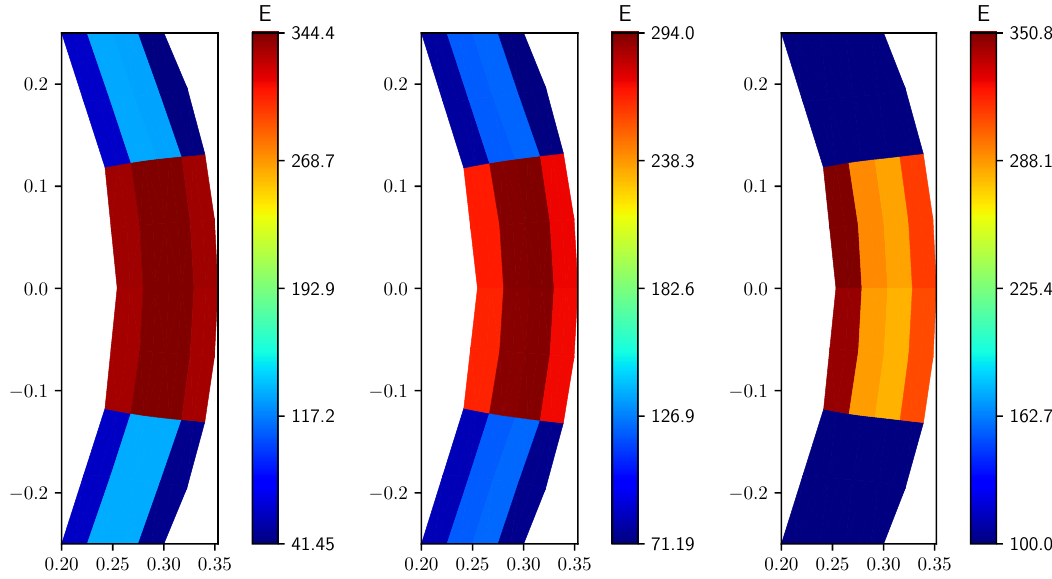
Figure 5. Young modulus E fields, discretization l = 2 with different E min = 10 Pa ( left ), 50 Pa ( center ), 100 Pa ( right ). E and E min are scaled by 2.4